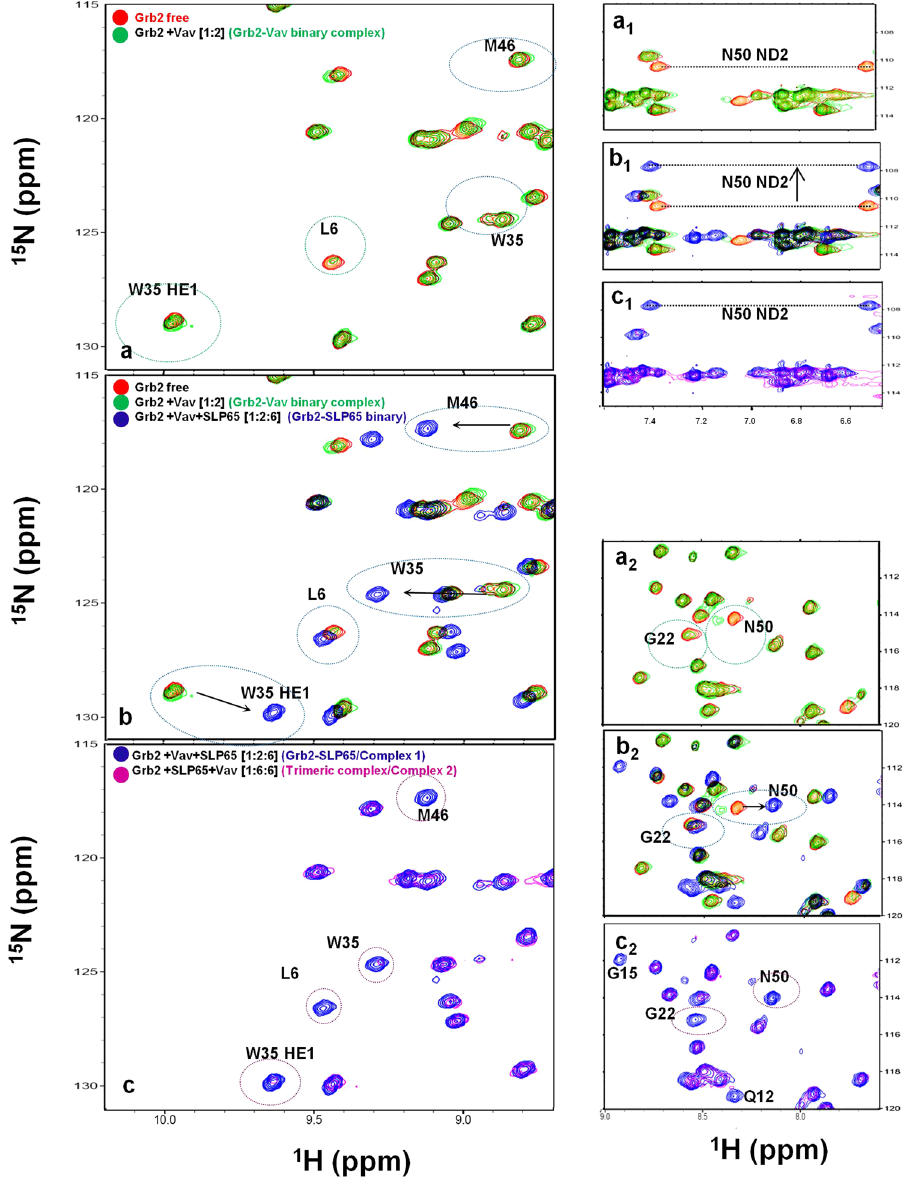
Figure 4. 1 H 15 N HSQC spectra of the Grb2 SH3C domain in complex with its ligands. ( a , a 1 , a 2 ) 1 H 15 N HSQC spectra of the free Grb2 SH3C (red), superimposed on the spectra of Grb2SH3C-Vav SH3N complex, 1:2 molar ratio (green). ( b , b 1 , b 2 ) Multiple overlaid spectra of free Grb2 SH3C (red), Grb2 SH3C-Vav SH3N complex (green), and Grb2 SH3C-Vav SH3N complex after addition of six-fold molar excess of SLP65 peptide, resulting in Grb2-SLP65 complex (Complex 1, blue). ( c , c 1 , c 2 ) Overlaid spectra of the Grb2-SLP65 complex, (Complex 1, blue), and the trimeric complex SLP65-Grb2-Vav, formed upon addition of six-fold excess of Vav SH3N (Complex 2,